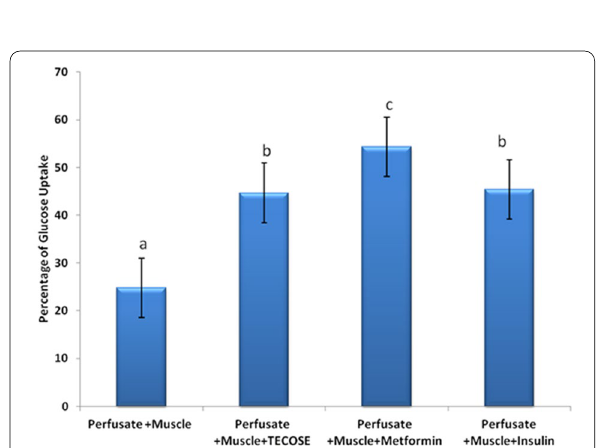
Fig. 8 Percentage glucose uptake by muscle in the control and treatment groups. Values are expressed as mean with different Tukey superscripts are statistically significant at p < 0.05